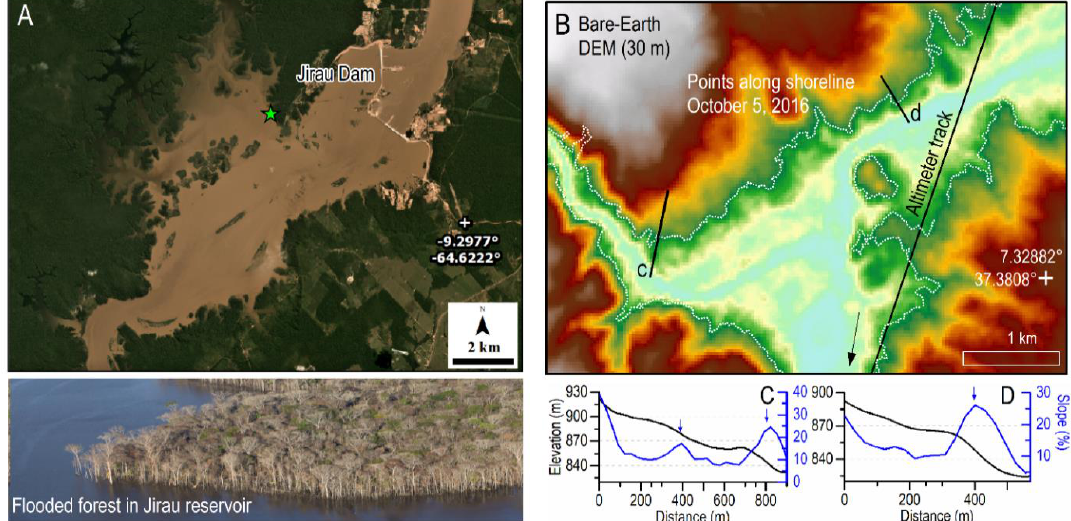
Figure 6. ( A ) High resolution PlanetScope image on May 2018 showing the maximum seasonal flooded area over the Jirau reservoir. Dense forests are flooded along most of the fringes of the reservoir. Aerial photo taken in June 2014 at the location of the green star symbol in the map. ( B ): Sentinel–derived points shoreline points over the Gilgel reservoir on 5 October 2016 overlaid on the bare–Earth DEM used in this study. Two convex elevation profiles and corresponding slopes are shown (C and D).